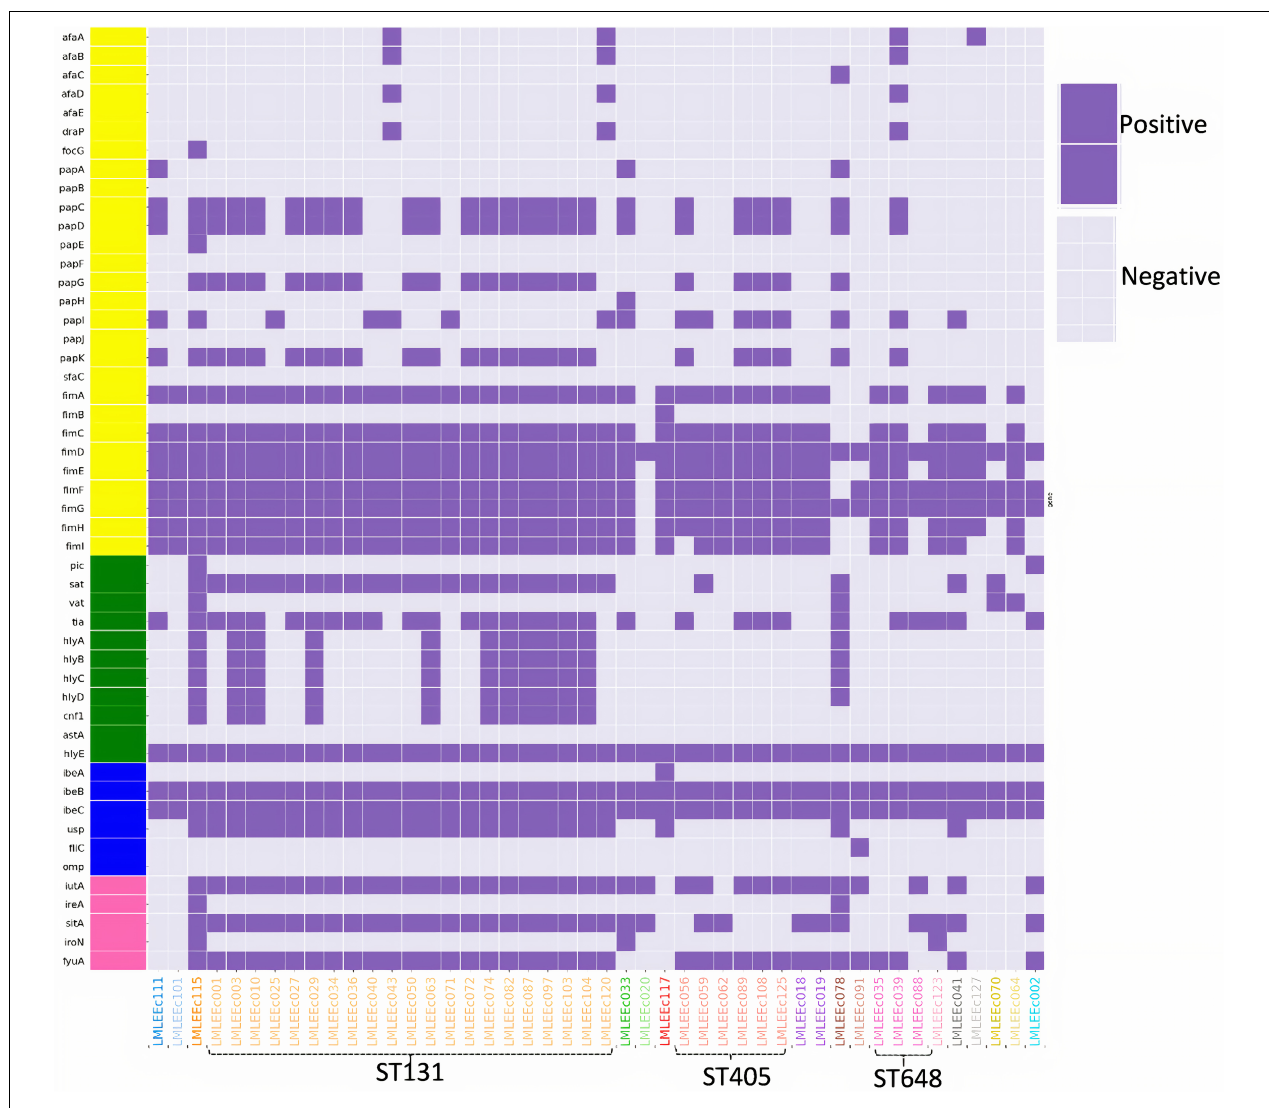
FIGURE 3 | Distribution of virulence gene profiles within 46 E. coli isolates are represented in the heatmap, with colored blocks indicating the gene presence and gray-colored blocks indicating the gene absence. Further, the virulence genes are vertically colored coded by functional categories (yellow, adhesins; blue, toxins; pink, miscellaneous; green,